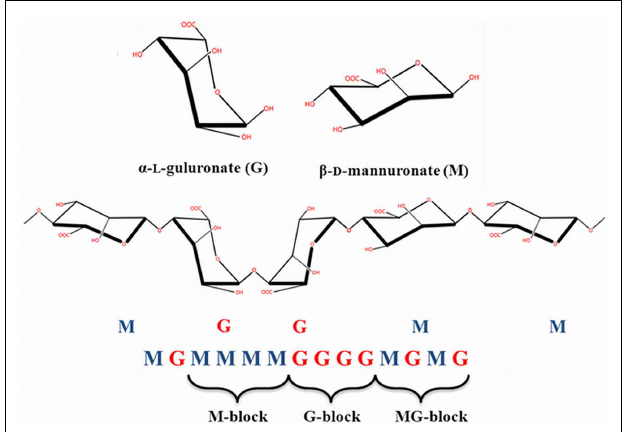
FIGURE 3 | Chemical structure of alginate . Linear block polymers of β - D -mannuronate (M) and - L -guluronate (G) with a variation in composition and sequential